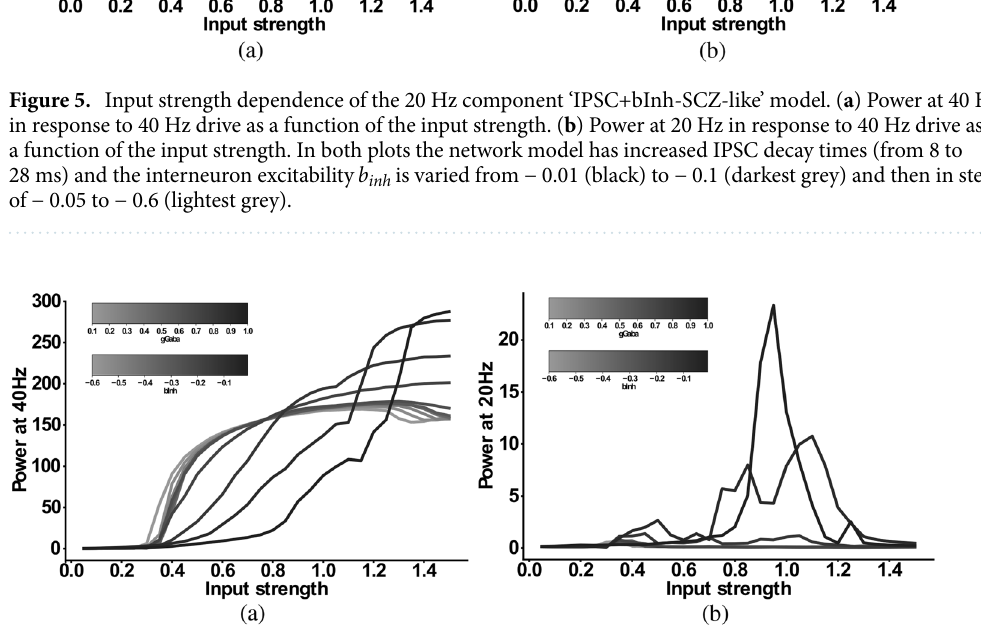
Figure 6. Input strength dependence of the 20 Hz component ‘Full-SCZ-like’ model. ( a ) Power at 40 Hz in response to 40 Hz drive as a function of the input strength. ( b ) Power at 20 Hz in response to 40 Hz drive as a function of the input strength. In both plots the network model has increased IPSC decay times (from 8 to 28 ms) and now both the I-E and I-I synaptic strength ( g ie and g ii , respectively) is varied from 100% (black) to 10% (lightest grey) in steps of 10% and simultaneously the interneuron excitability b inh is varied from − 0.01 (black) to − 0.1 (darkest grey) and then in steps of − 0.05 to − 0.6 (lightest